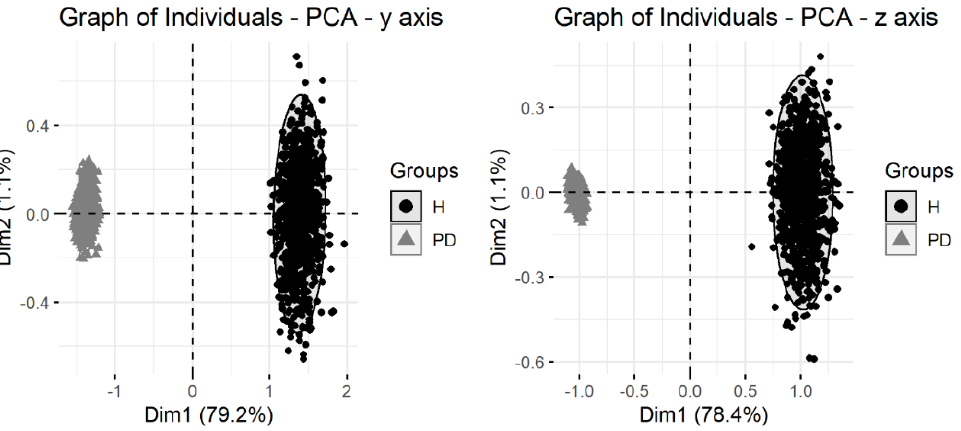
Figure 11 shows that the adopted method employing capacitive sensors can distinguish between PD patients and healthy older adults. The graph of individuals for radial-ulnar— y-axis (S1) and proximal-distal—z-axis (S2) depicts the dimension of the two first principal components for each axis, which represents the percentage of variances explained, and they are sufficient to distinguish between the two groups.